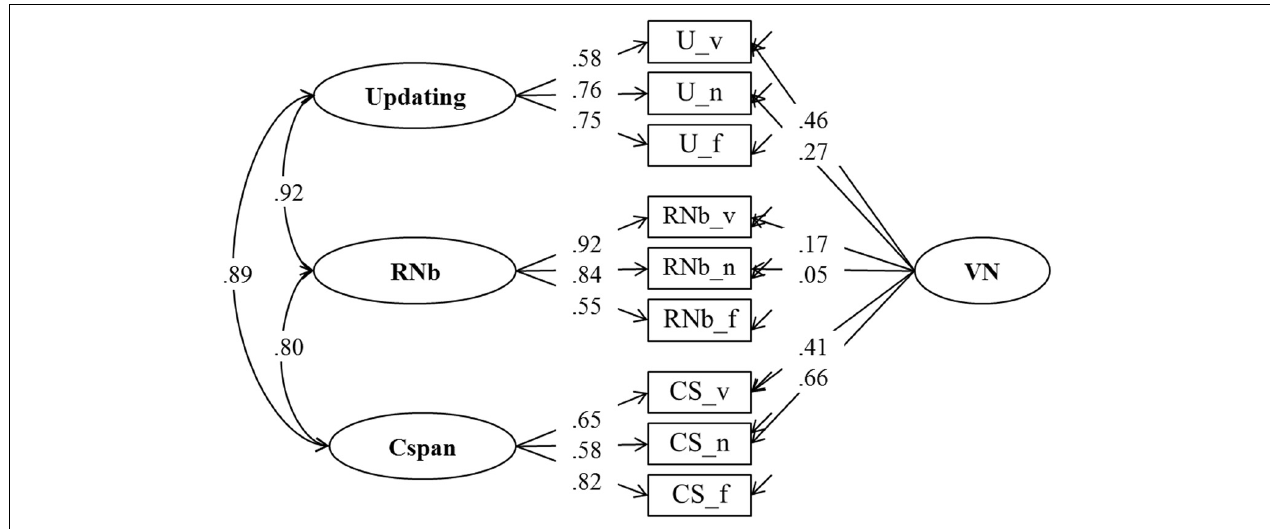
FIGURE 3 | Confirmatory factor analysis of updating, Recall 1-back (RNb) and Complex Span (Cspan) Tasks (Model 1). The model postulates a verbal-numerical nested factor (VN that is orthogonal to task class specific factors). _v, verbal indicators; _n, numerical indicators; _f, figural indicators.